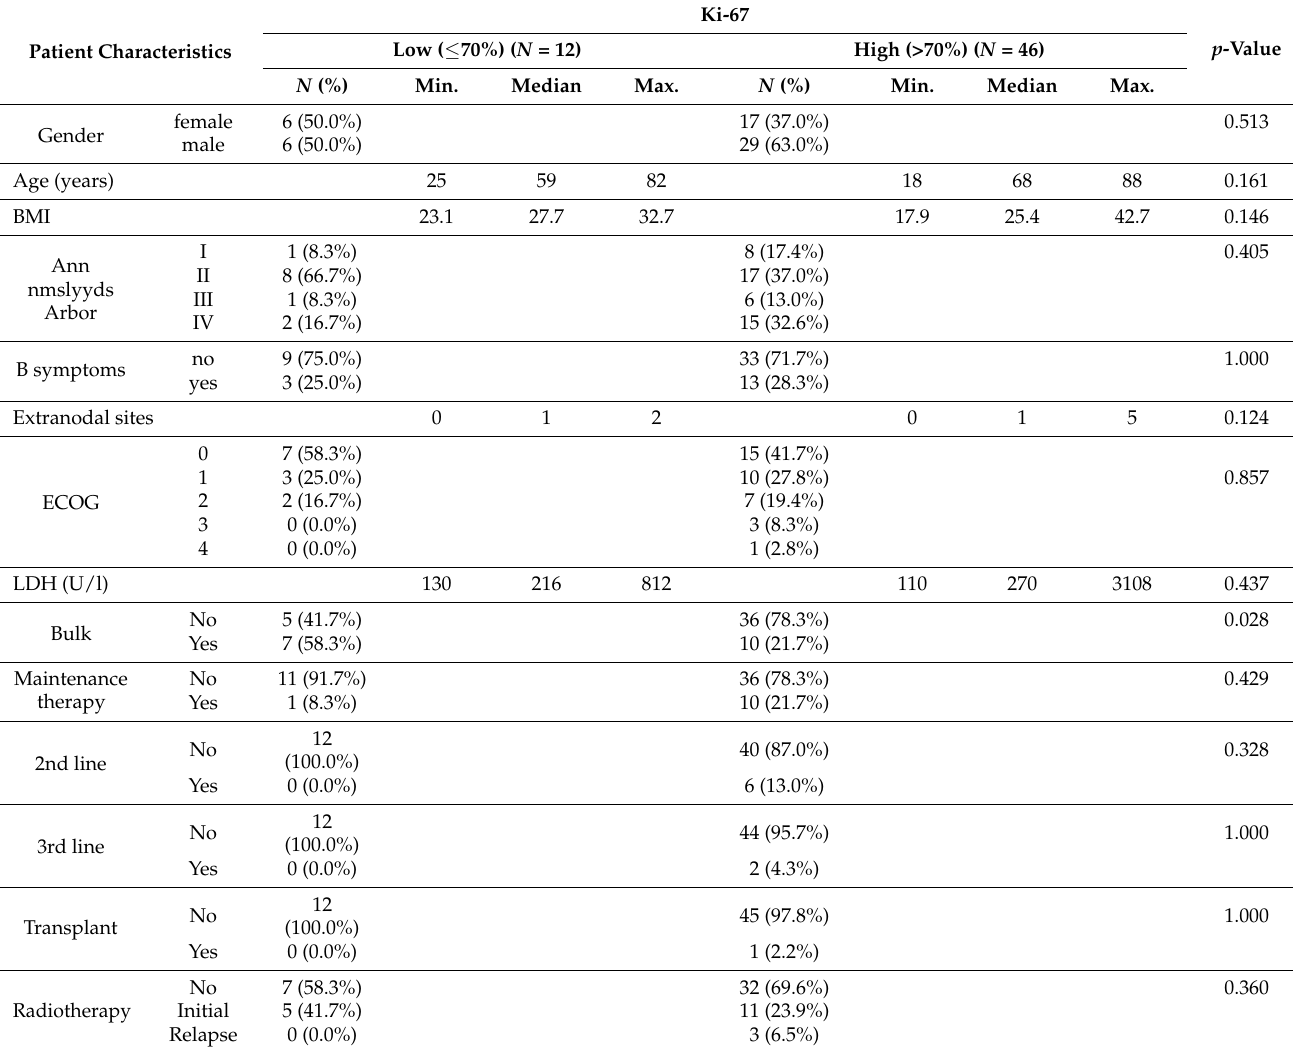
Table 1. Demographic characteristics of the patient cohort.